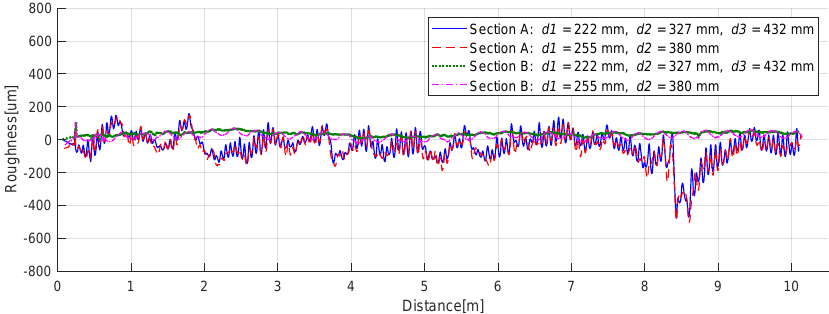
Figure 9. Rail surface roughness of track sections in tunnel